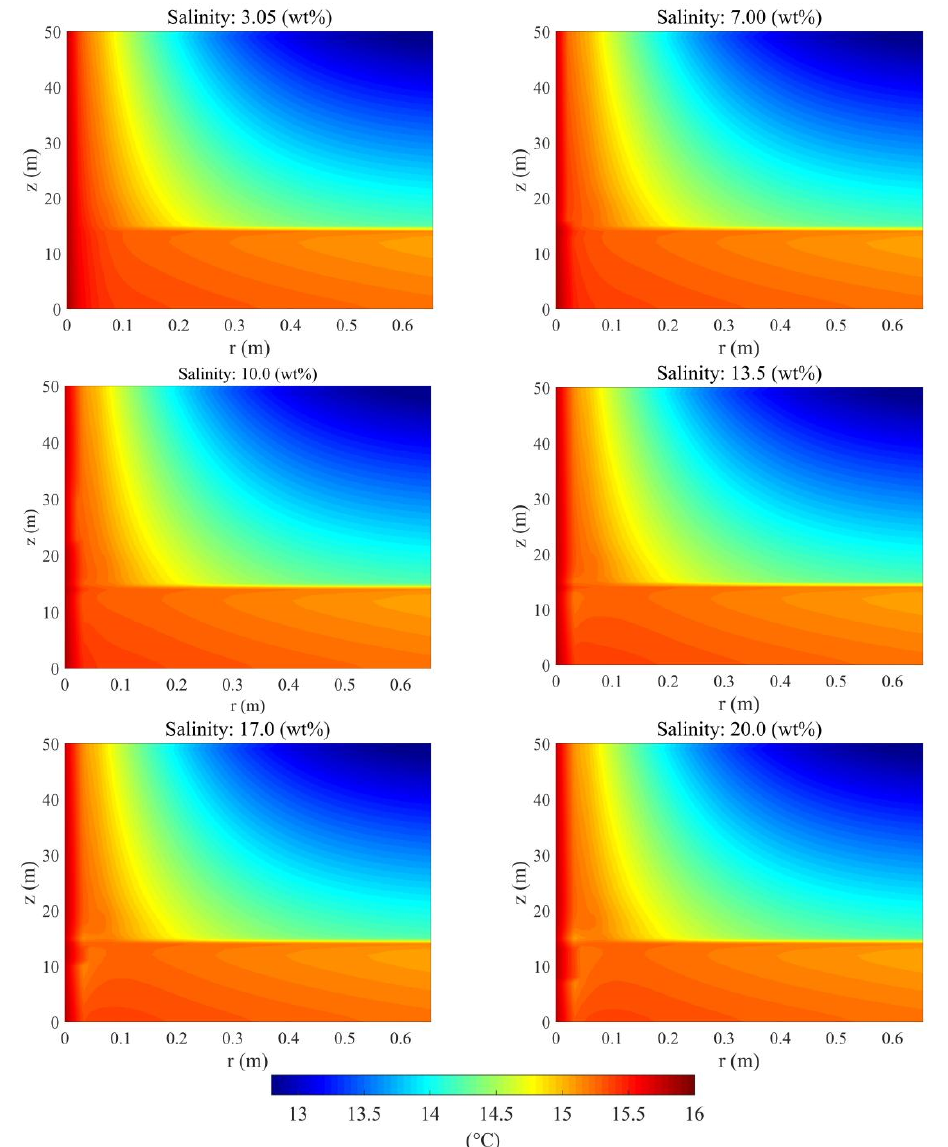
Figure 13. Comparison of two-dimensional temperature distribution of hydrate reservoirs for a fixed temperature of 16 °C at the 24th hour of drilling fluid invasion under various drilling fluid salinity values.